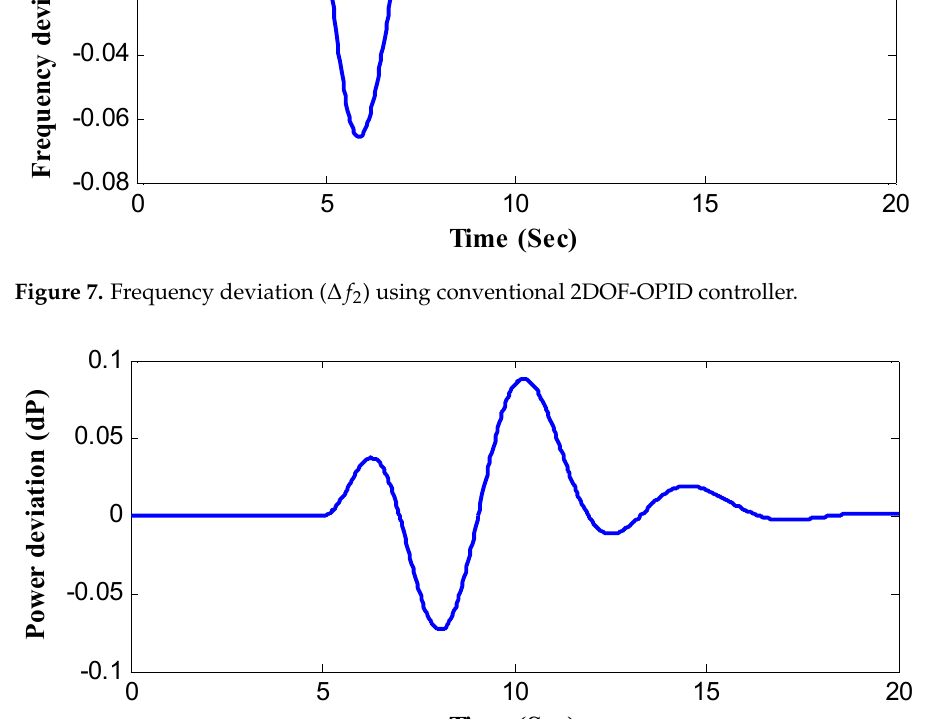
Figure 8. Tie-line Power deviation ( Δ P) using conventional 2DOF-PID controller.